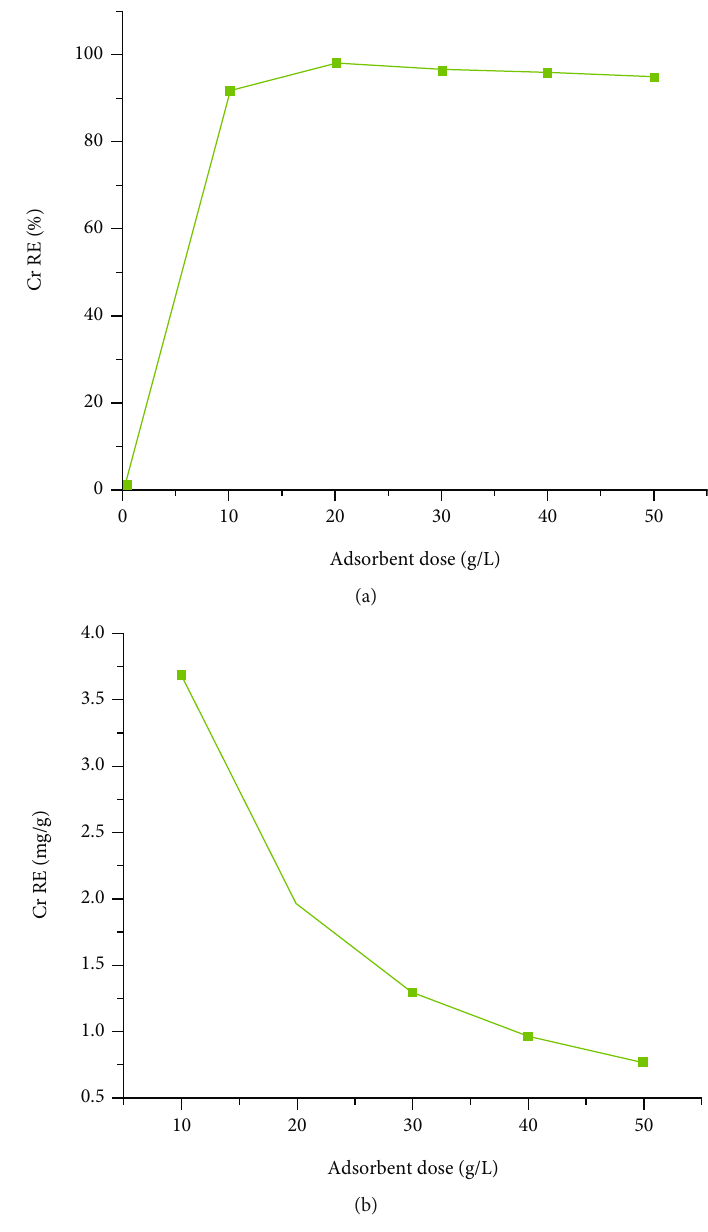
Figure 4: Adsorbent dose e ff ects on Cr (a) % RE and (b) mass adsorption e ffi ciency (mgg -1